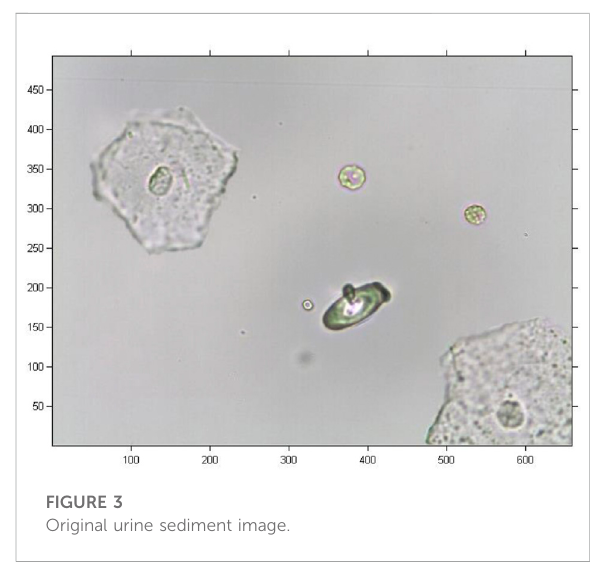
FIGURE 3 Original urine sediment image.